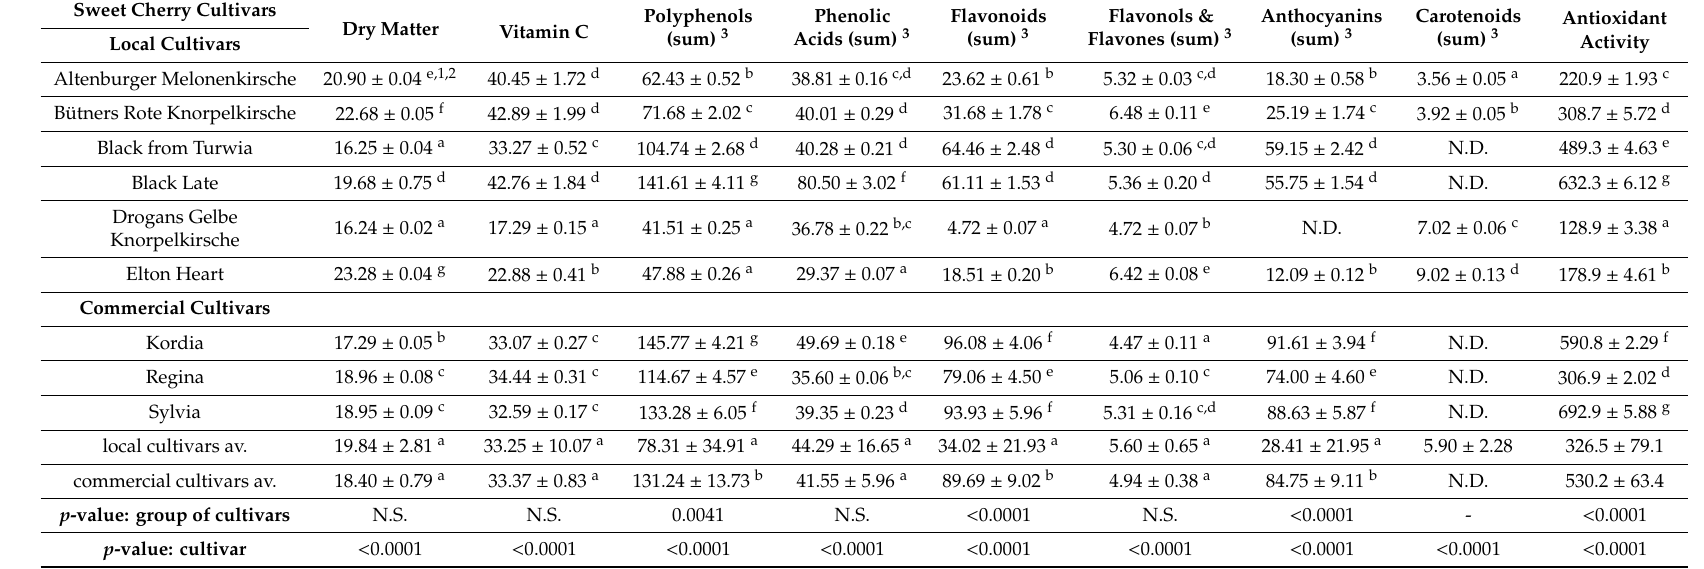
Table 2. The content of dry matter (in g 100 g − 1 FW), vitamin C, polyphenols, carotenoids (in mg 100 g − 1 FW) and antioxidant activity (mmol Trolox 100 g − 1 FW) in sweet cherry fruit harvested in